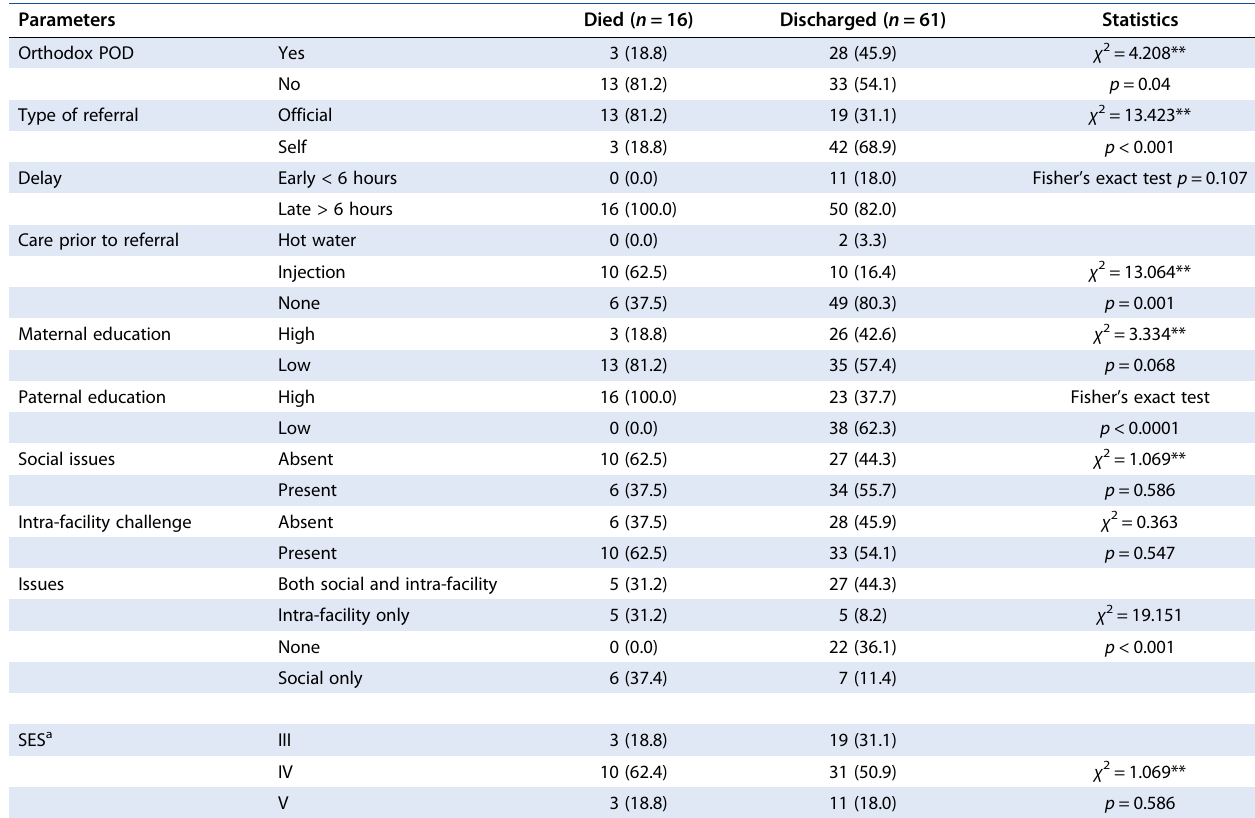
Table 3: Factors associated with immediate outcome of 77 babies with HIE*